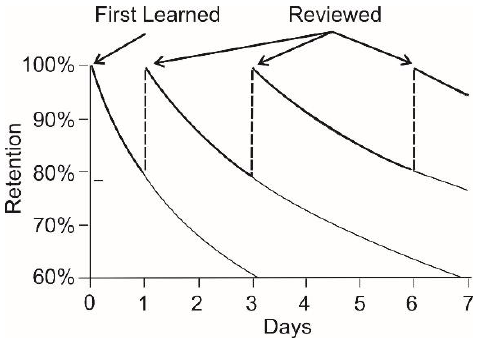
Fig. 6 . The learning – forgetting